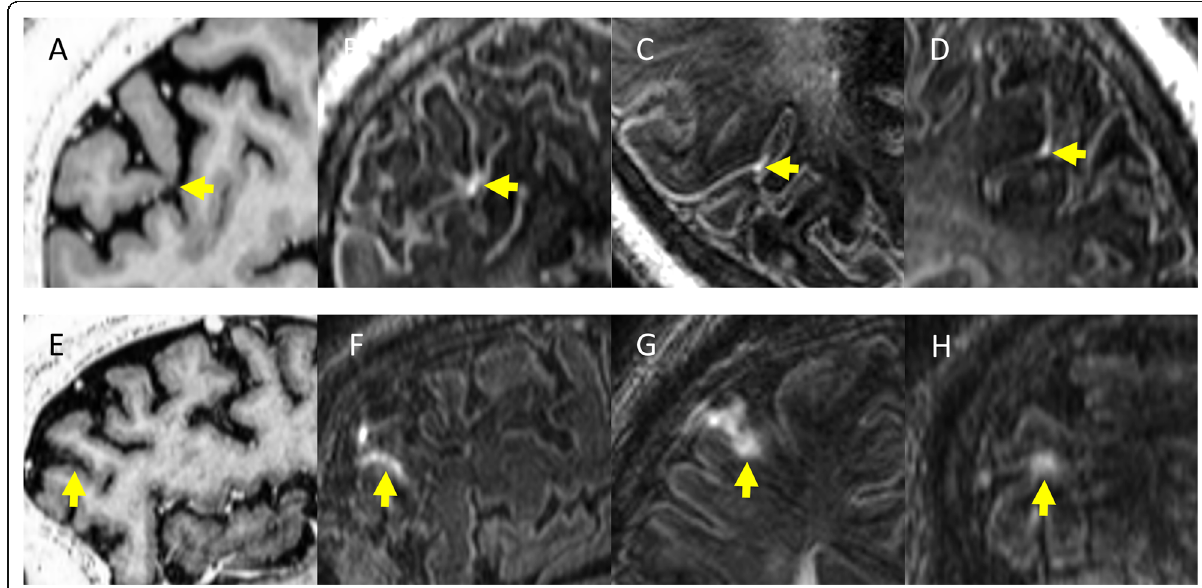
Fig. 3 Examples of “ spread/fill ” type enhancing foci in multiple sclerosis. In the horizontal rows are displayed two different patients. Contrast- enhanced T1-weighted magnetisation-prepared two rapid gradient echo images ( A , E ), along with axial ( C , G ), sagittal ( D , F ), and coronal ( B , H ) slices from contrast-enhanced magnetisation-prepared fluid-attenuated inversion recovery images. The yellow arrows indicate the location of a spread/fill focus of leptomeningeal contrast enhancement in all the three planes and its expected location on T1-weighted